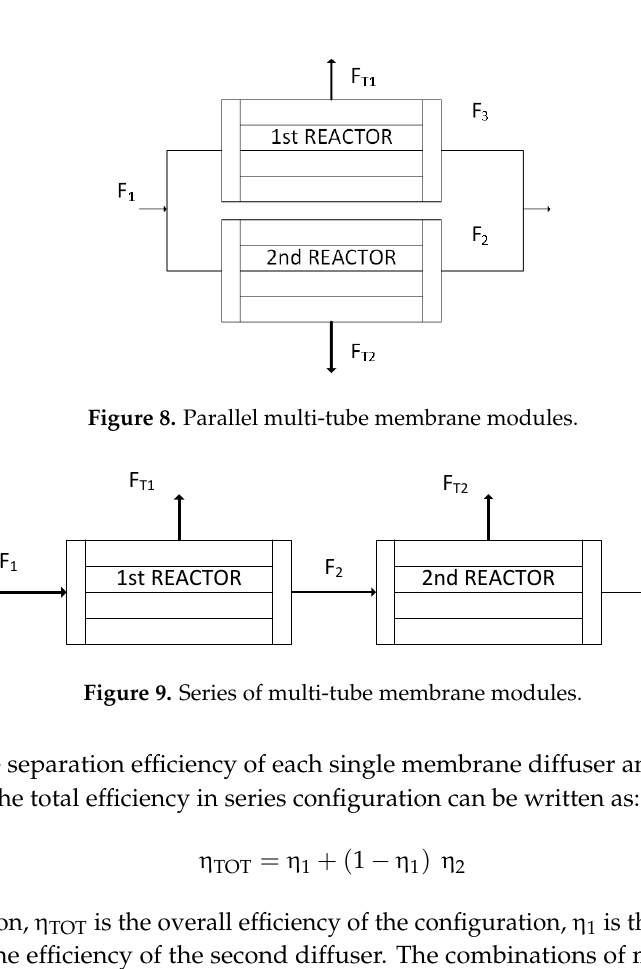
Figure 9. Series of multi-tube membrane modules.